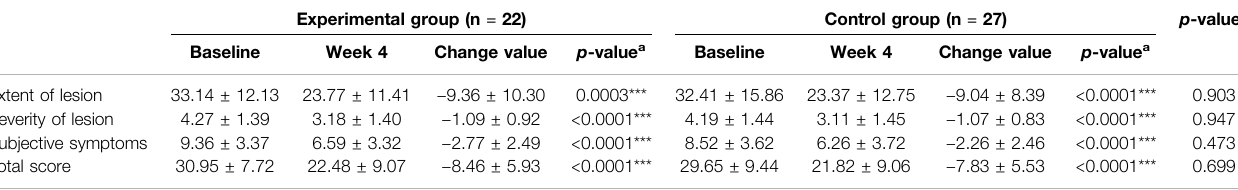
TABLE 3 | Changes in the SCORAD index.